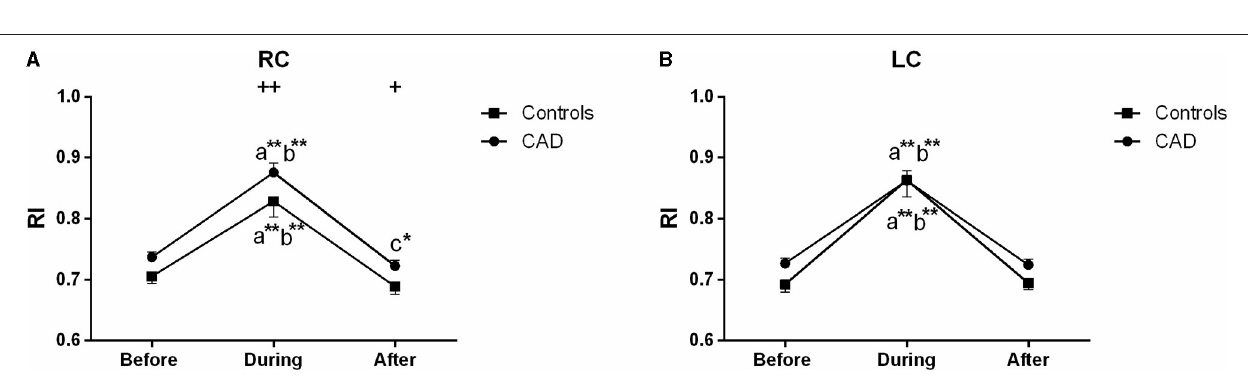
FIGURE 6 | Effect of EECP on the resistance index (RI) of RC (A) and LC (B) in the patients with CAD and controls before, during, and after a 45min-EECP. a indicates significant differences in measurements obtained during EECP vs. pre-EECP; b indicates differences between post-EECP vs. during-EECP, and c refers to comparisons between post-EECP vs. pre-EECP. * and ** denote p < 0.5 and < 0.01 respectively. + and ++ denote p -values of the difference between groups < 0.5 and < 0.01,